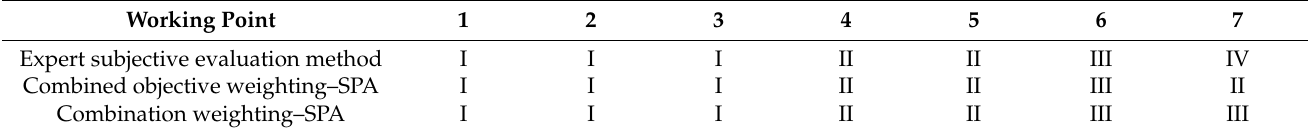
Table 7. Comparison of Evaluation